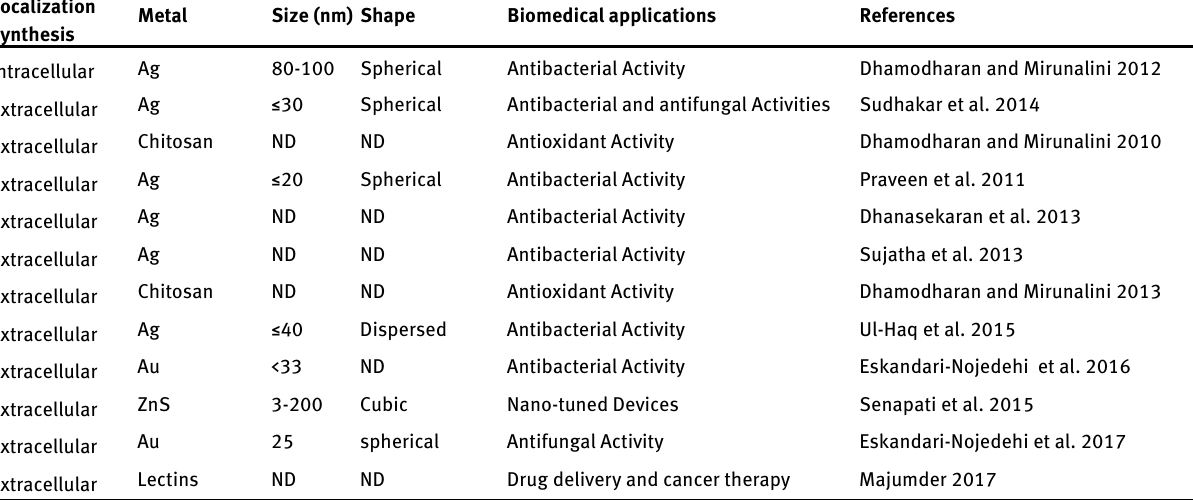
Table 6: Biosynthesis nanoparticles by using A. bisporus (white button mushroom)